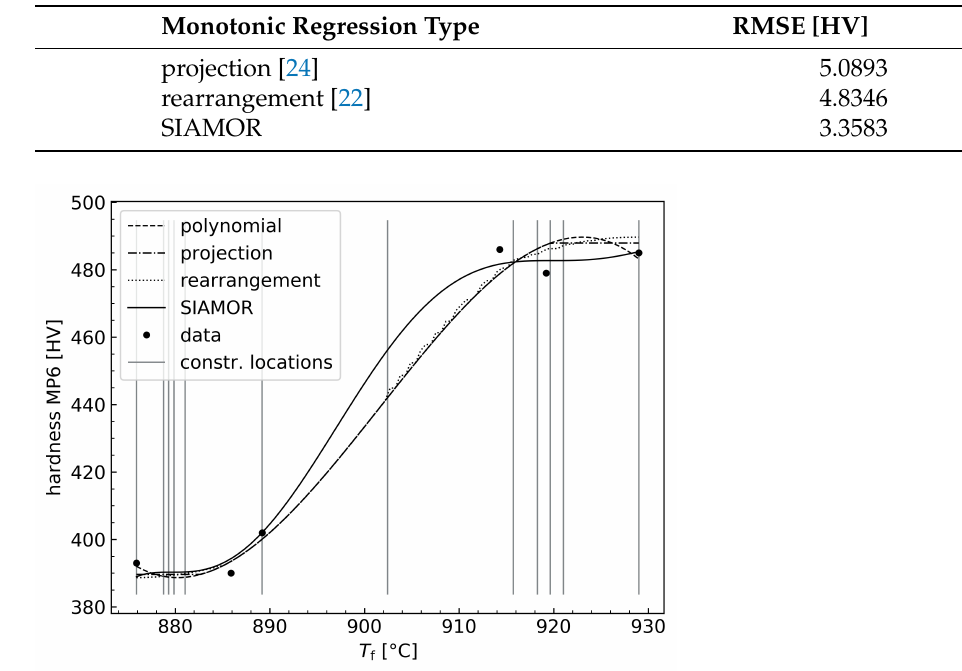
Figure 5. 1D regression for forming and press hardening of sheet metal ( F p = 2250kN, ∆ t h = 4s, t q = 2s). Dashed: (non-monotonic) polynomial of degree m = 3 as the reference model, dash- dotted: projection [24], dotted: rearrangement [22], solid: SIAMOR (see Sections 2.1–2.3) with degree m = 6. The projection and rearrangement methods were fed with the dashed polynomial curve as non-monotonic reference